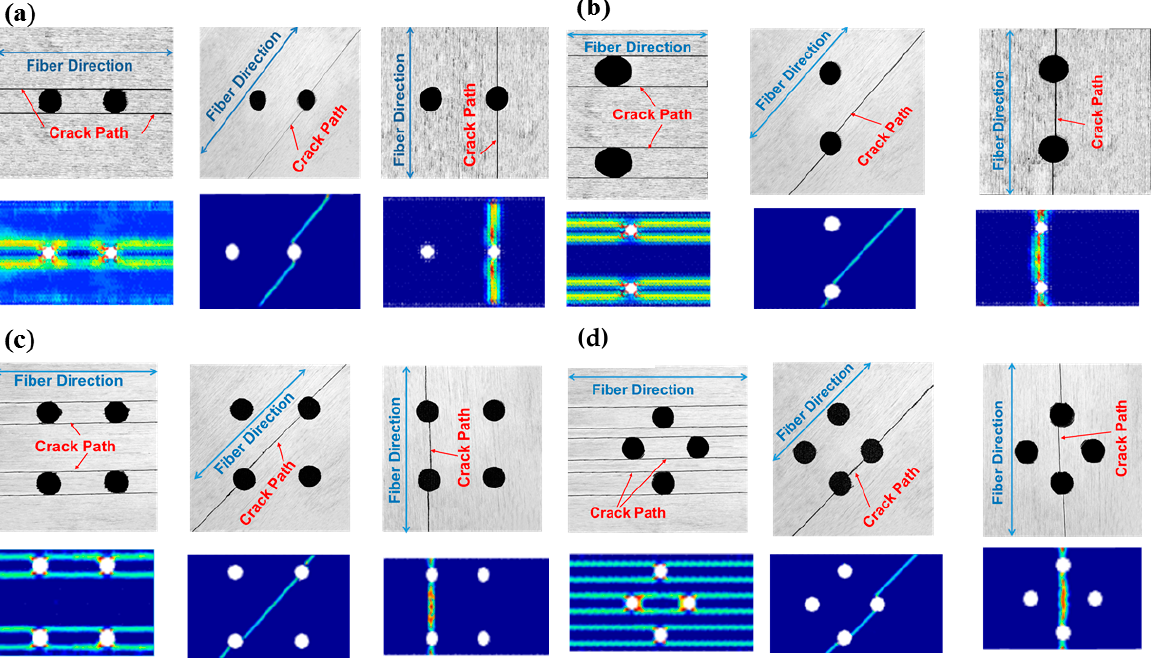
Figure 8. Validation of crack propagation in unidirectional plates with different fiber directions and ( a ) two horizontal holes, ( b ) two vertical holes, ( c ) four square holes, and ( d ) four diamond holes.